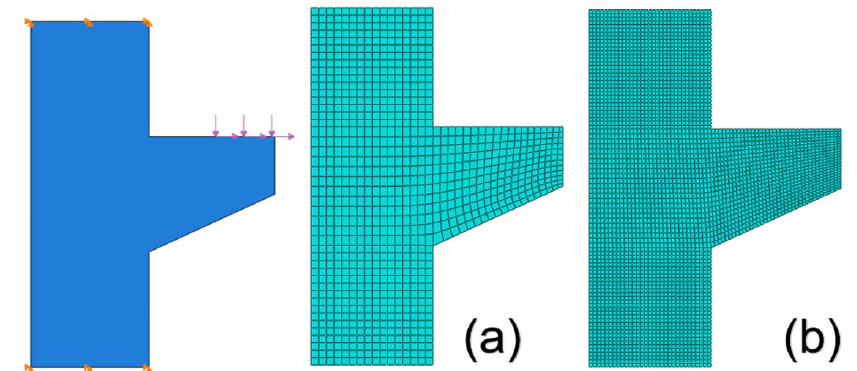
Figure 13. Boundary conditions and analyzed meshes a) dimension of 50 mm; b) dimension of 25